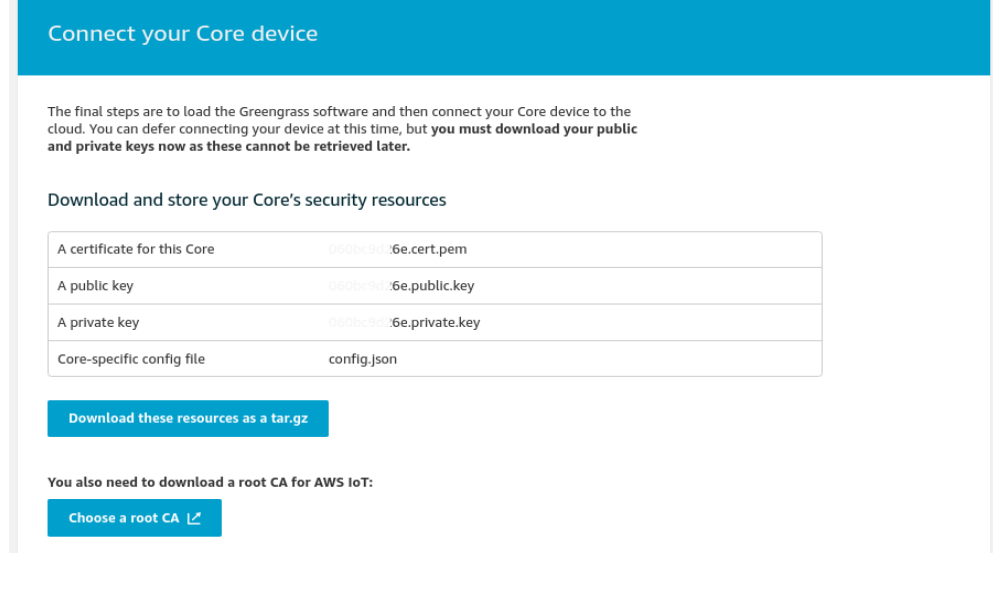
Figure 4. Certificate, private and public keys .